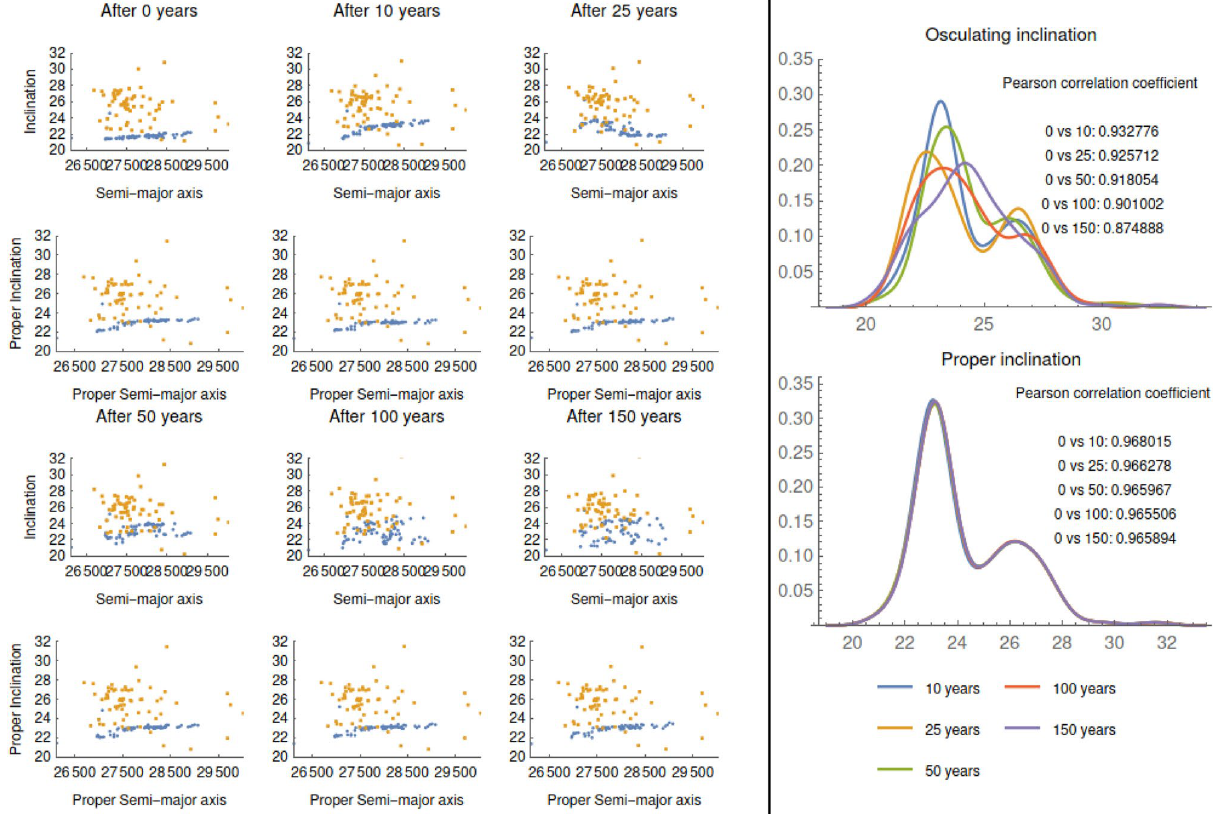
Figure 4. Mixed case between CZ-3 and Atlas V Centaur. Evolution of both the osculating and proper inclination over 10, 25, 50, 100, 150 years (left); the histograms and the Pearson correlation coefficients between osculating and proper inclinations